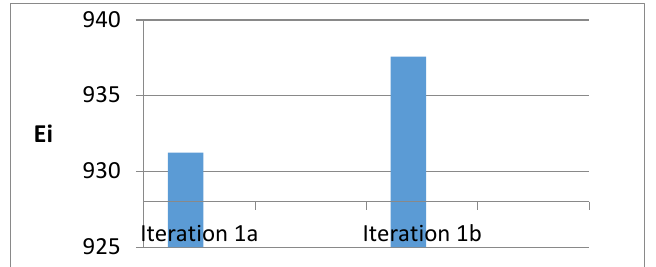
Fig.15 Graph for Economic Index with and without